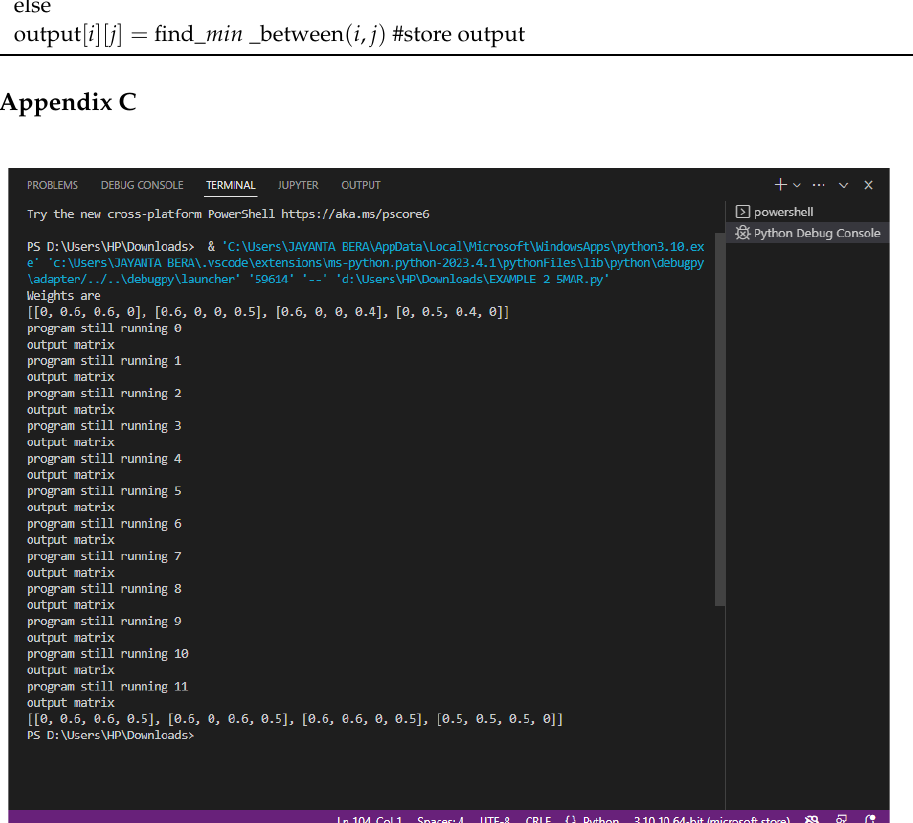
Figure A1. Output of Appendix A.